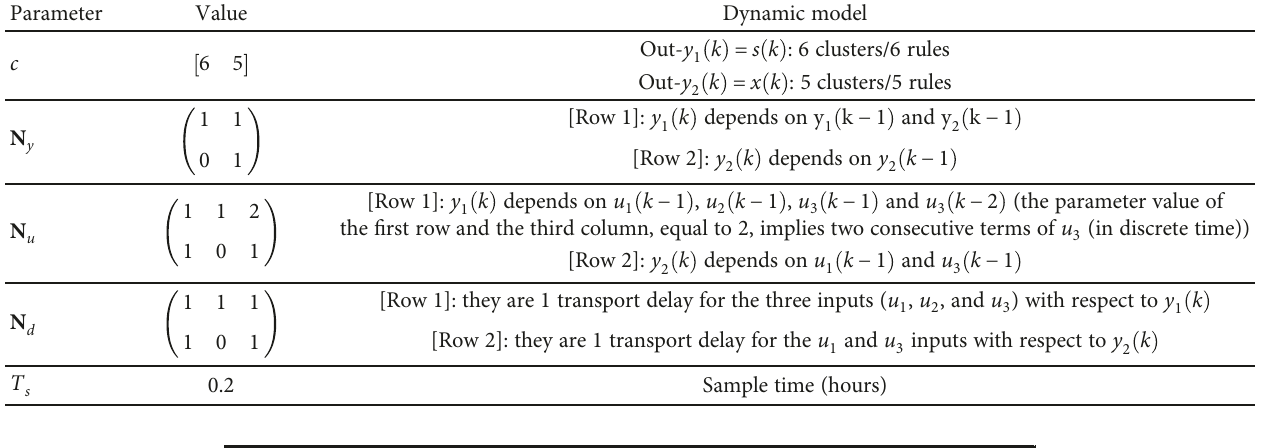
Table 4: Structural parameters in case D.